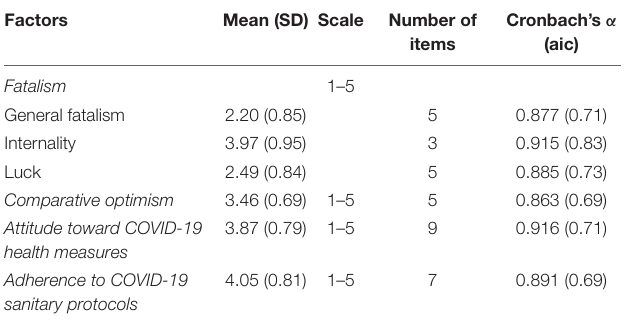
TABLE 1 | Reliability and internal consistency of the